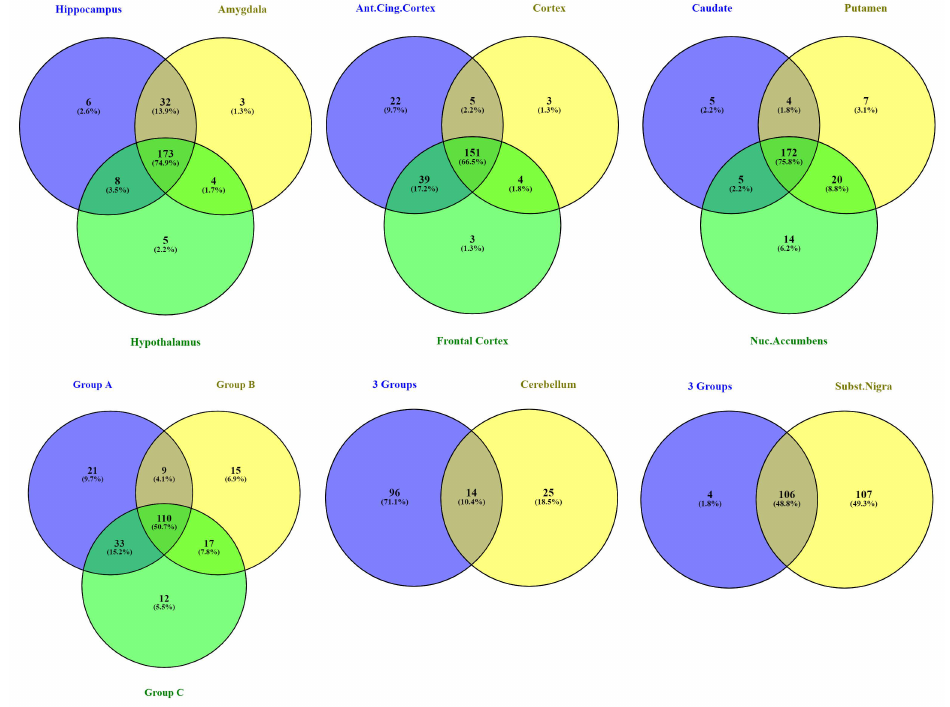
Figure 5. Venn diagrams representing the intersection of co-expressed genes in different brain regions and combinations of